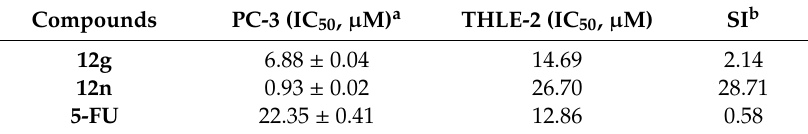
Table 2. IC 50 of the derivatives 12g and 12n with PC-3 and THLE-2 cell lines.